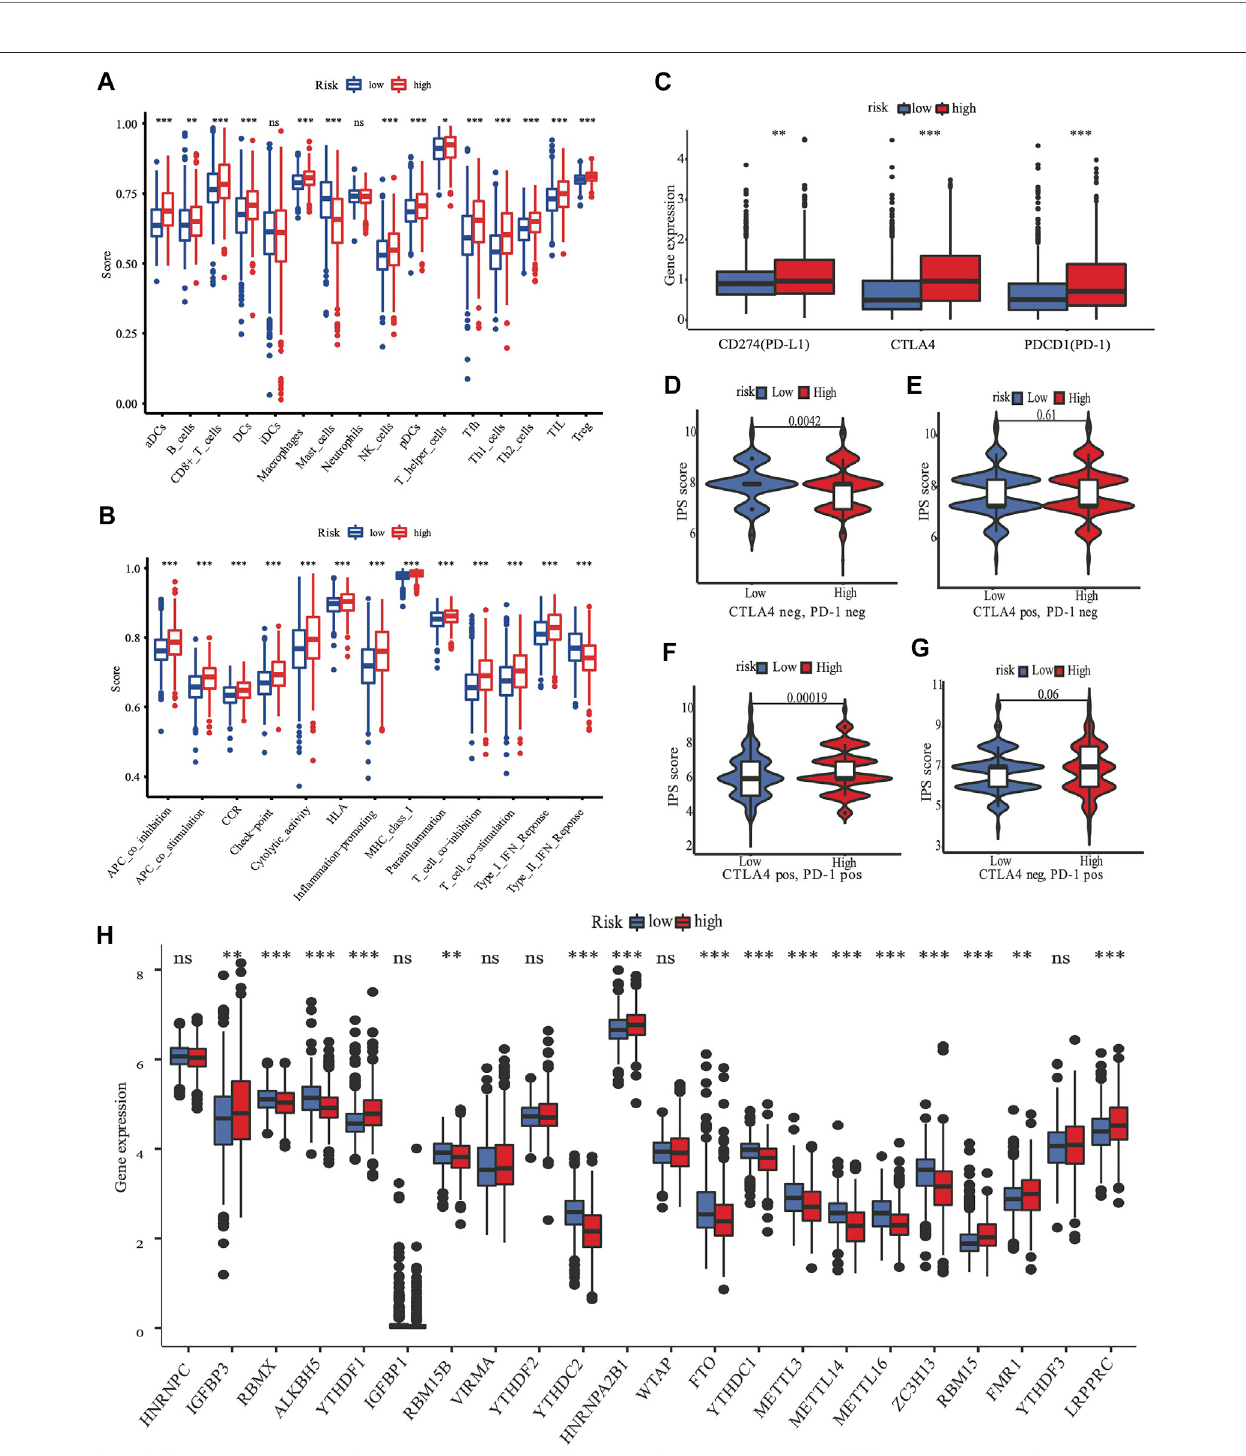
FIGURE6| Theroleofnine-genepanelinimmunotherapybasedonTCGAcohort.Boxplotsdepictthescoresof16immunecells (A) and 13immune-related roles (B) in high and low risk subgroup by “ ssGSEA ” . Expression of immune checkpoints among high and low subgroups, such as CTLA4, PD-L1, PD-1 (C) ; The immunophenoscore (IPS) distribution was also compared between high and low risk subgroups (D – G) . The gene expression levels of 22 m6A from TCGA cohort between two subgroups (H) . (ns, not signi fi cant; * p < 0.05; ** p < 0.01; *** p < 0.001; pos means positive; neg means negative).